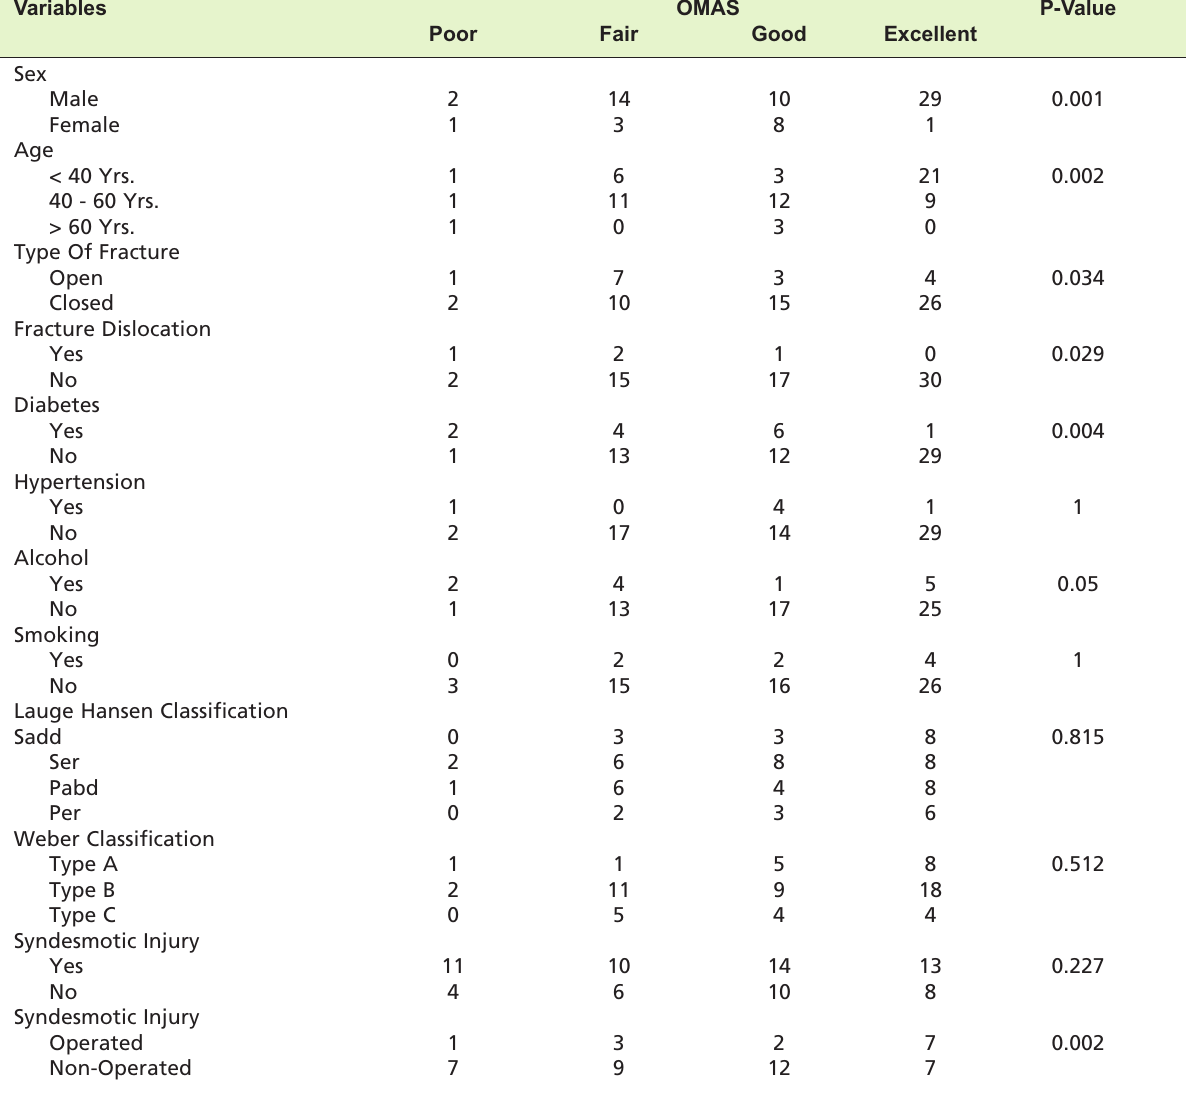
Table showing variables that affect the OMAS score Table II: